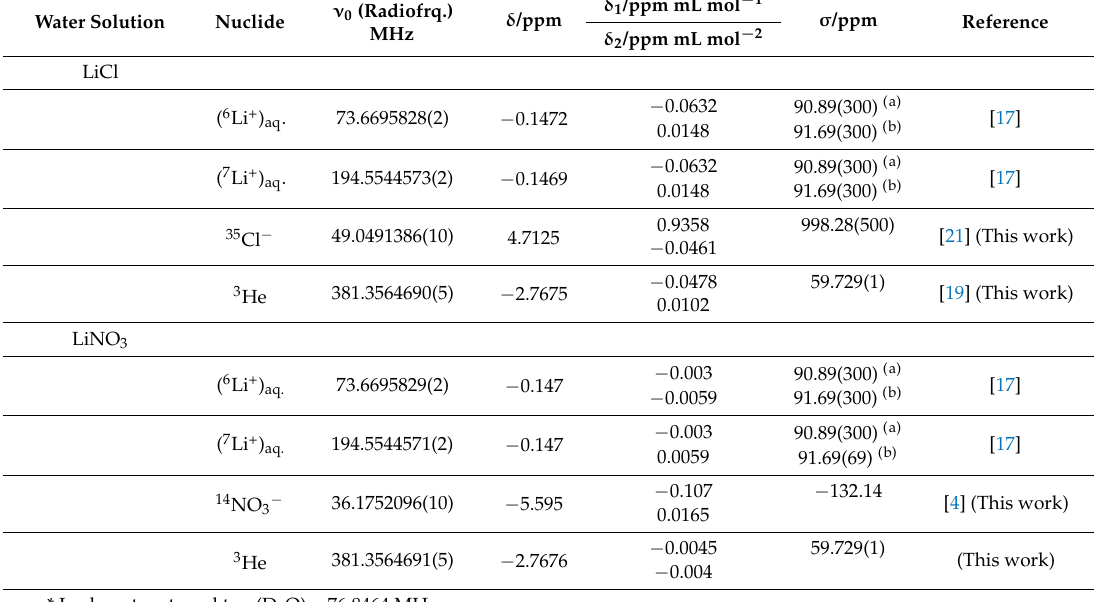
Table 1. NMR parameters measured in LiCl and LiNO 3 water solutions*. Shielding results of 6 Li + and 7 Li + cations calculated for: (a) six-coordinated and (b) four-coordinated water